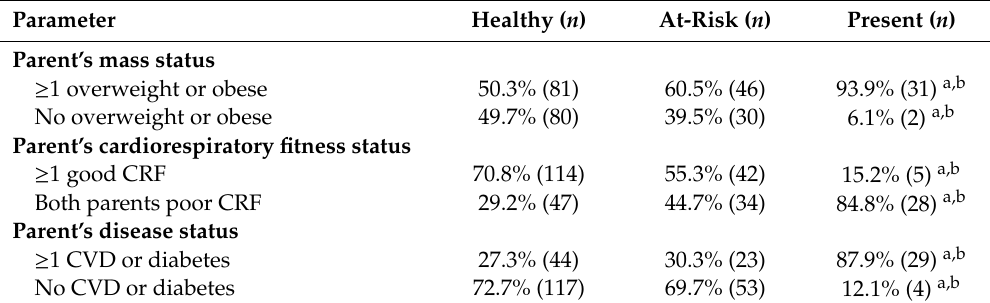
Table 3. Prevalence of participants in each metabolic syndrome group with a parent with or without poor cardiorespiratory fitness, increased body mass, or cardiometabolic